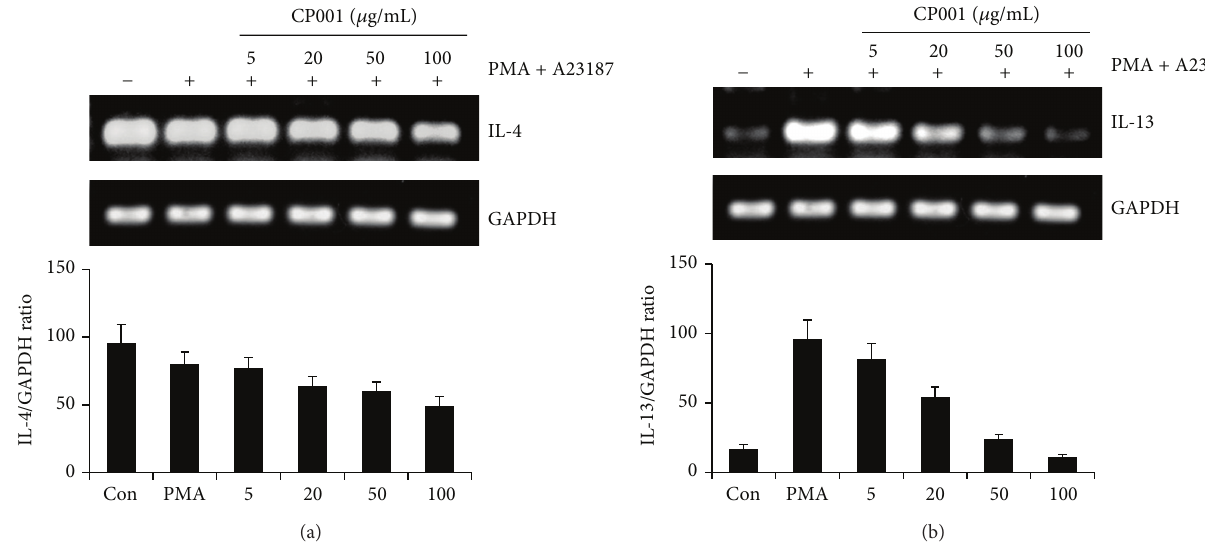
Figure 7: Effect of CP001 on PMA plus A23187-stimulated Th2 cytokine expression in HMC-1. HMC-1 were pretreated with various concentrations of CP001 for 1 h and then treated with PMA and A23187 for 24 h. The IL-4 and IL-13 mRNA levels were measured by RT- PCR (a), (b). Data represent the mean ± SEMs of three independent experiments.